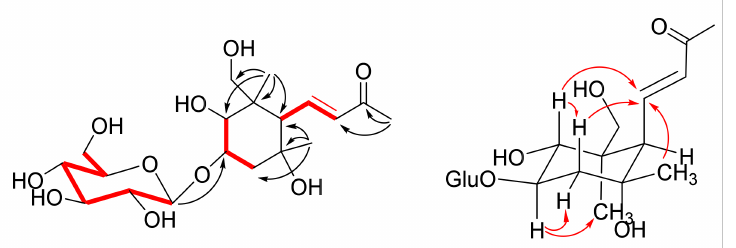
Figure 2. ( Left ): COSY (red bold) and HMBC (black arrows) correlations; ( right ): ROESY (red arrows) correlations of compound 5